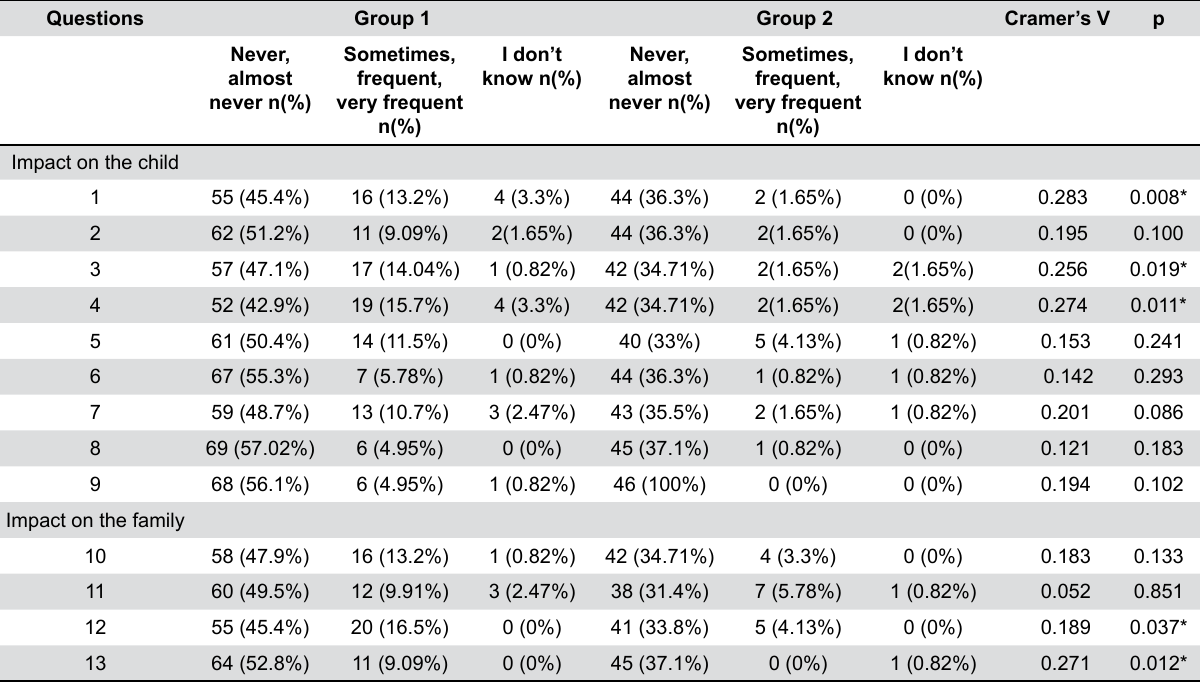
Table 2- Answers distributions to the questions 1−13 regarding the domains – impact on the child and on the